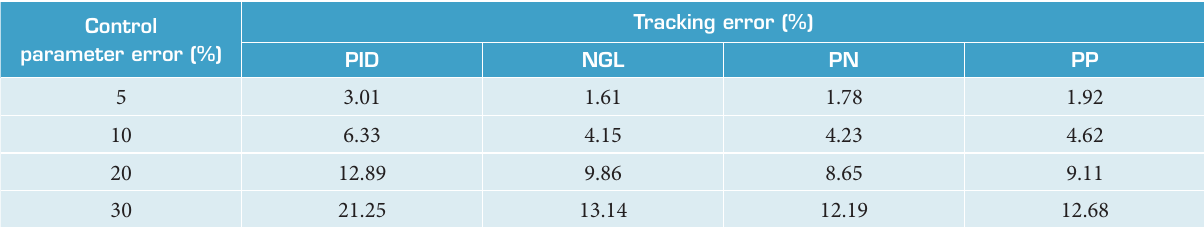
Table 1. Tracking error due to control parameter error.